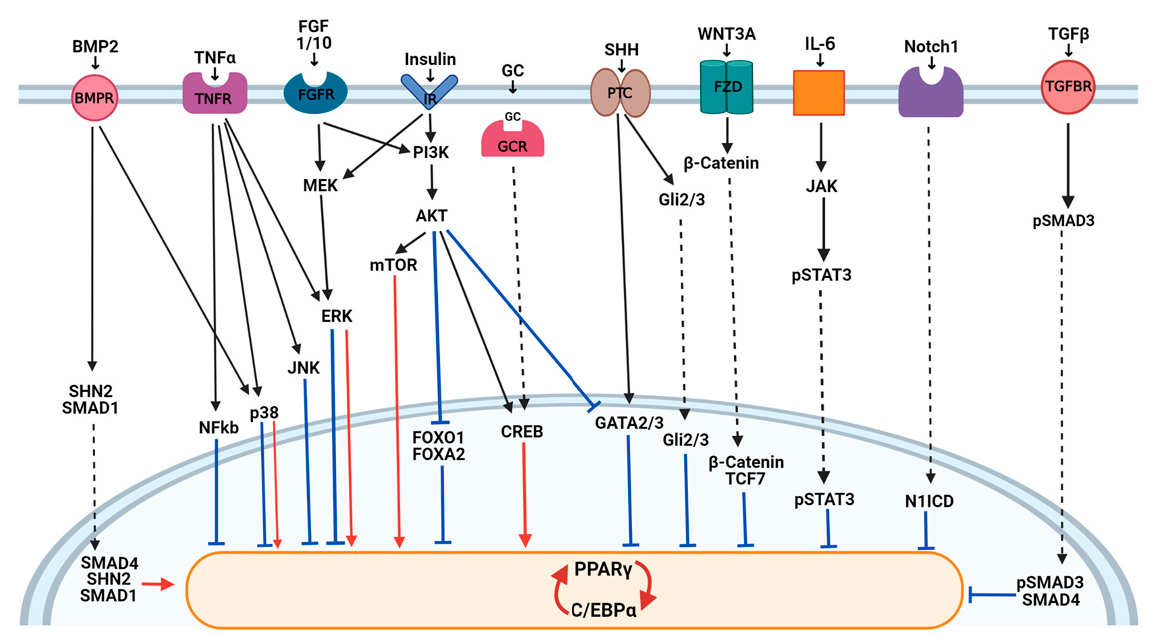
Figure 2. Extracellular regulators of adipogenesis. Signals from activators and repressors of adipogenesis are integrated in the nucleus by transcription factors that directly or indirectly activate (red arrows) or inhibit (blue lines) the expression of peroxisome proliferator-activated receptor γ (PPAR γ ) and CCAAT-enhancer-binding protein α (C/EBP α ). The induction of PPAR γ by p38 is related to the BMP2 pathway, and the red arrow from ERK is related to insulin and FGF pathways. AKT, protein kinase B; BMP, bone morphogenetic protein; CREB, cAMP response element-binding protein; ERK, extracellular signal-regulated kinase; FGF, fibroblast growth factor; FGFR, fibroblast growth-factor receptor; FOXO, forkhead protein; FZD, frizzled family receptors; GATA, GATA binding protein; GC, glucocorticoids; GCR, GC receptor; Gli, GLI family zinc finger; IL, interleukin; IR, insulin receptor; JAK, Janus kinase; JNK, Jun n -terminal kinase; MEK, mitogen-activated MAPK/ERK kinase; mTOR, mammalian target of rapamycin; N1ICD, Notch1 intracellular domain; NF-kB, nuclear factor kappa-light-chain-enhancer of activated B cells; Notch1; Notch homolog 1, translocation-associated; p38, protein 38 MAPK; PI3K, phosphatidylinositol-3 kinase; PTC, patched; SHN2, schnurri-2; SHH, sonic hedgehog; SMAD, SMAD family member; STAT, signal transducer and activator of transcription; TCF7, T-cell factor 7; TNF, tumor necrosis factor; TNFR, TNF receptor; TGF β , transforming-growth factor β ; WNT, wingless-related integration site.